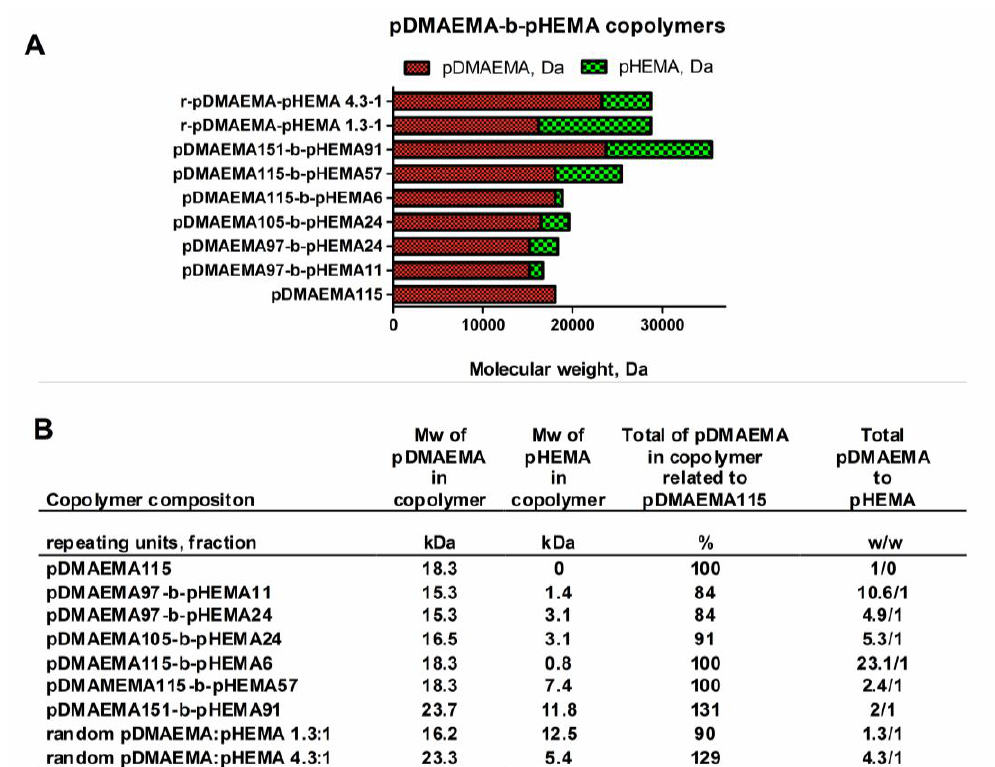
Figure 2. A, B The library of diblock copolymers sorted according to an increasing amount of pDMAEMA ( A ). The proportion and weight of each block-part in the various pDMAEMA-pHEMA copolymers were calculated according to the repeating units ( B